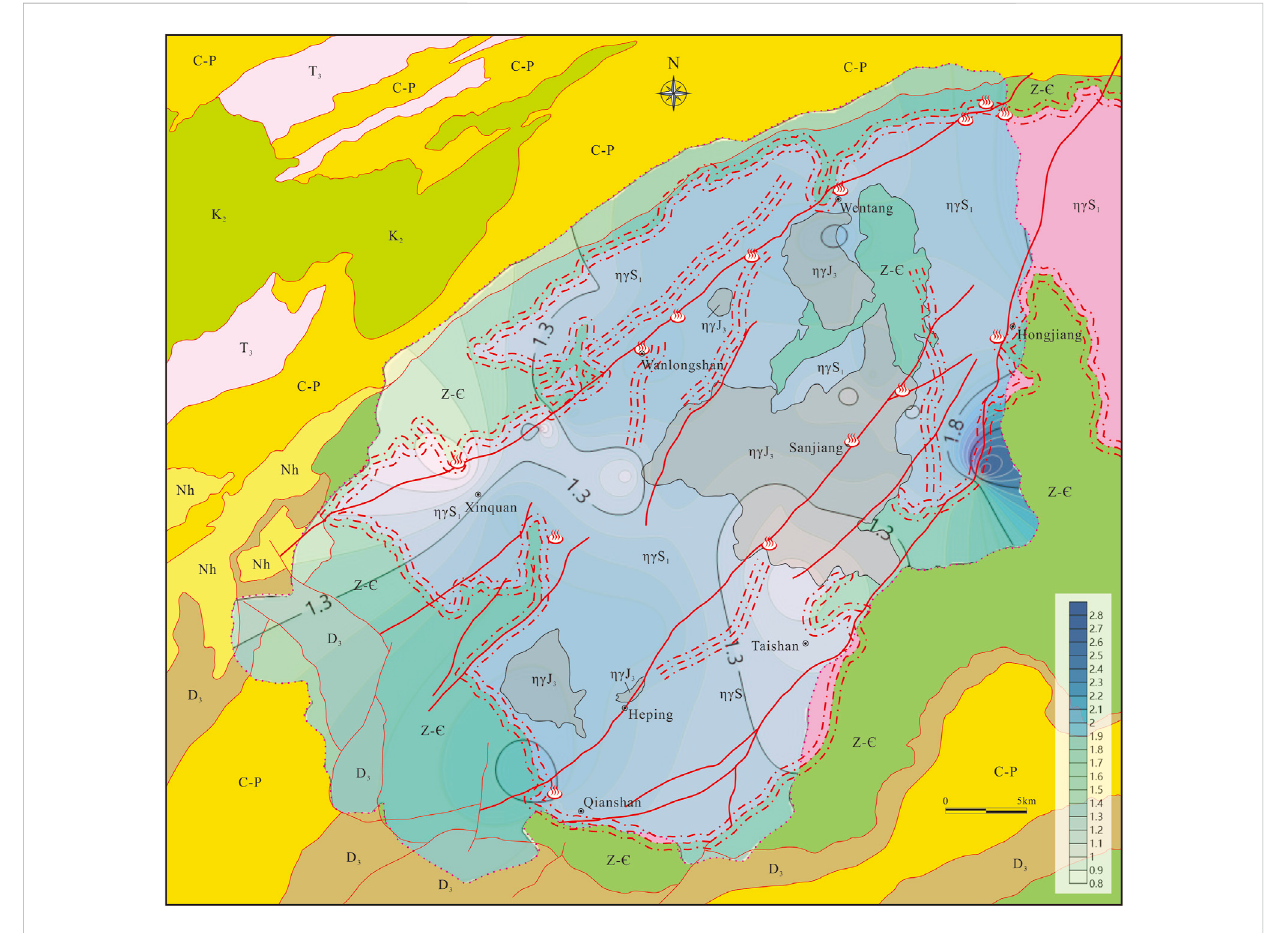
FIGURE 10 Coef fi cient curve of thermal conductivity and thermal diffusivity.